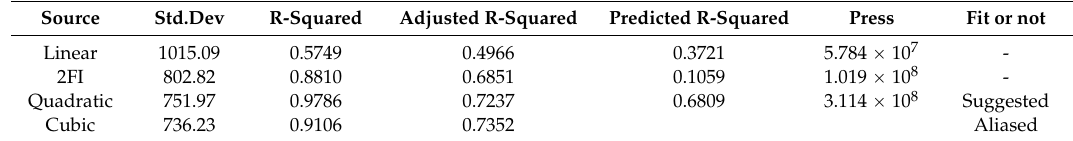
Table 4. Statistical approach to select the response surface methodology (RSM) model for SRA.